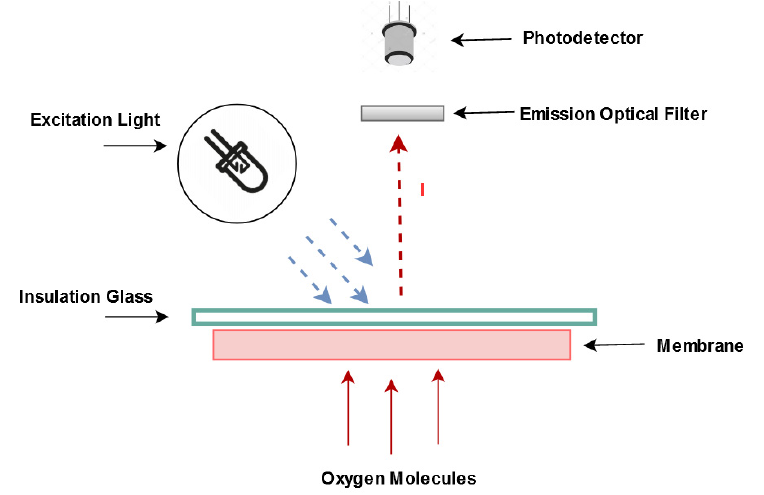
Figure 1. Diagram of a typical dissolved oxygen optical sensor.